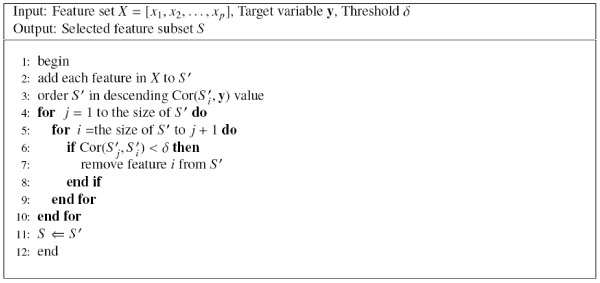
The RELIC algorithm.